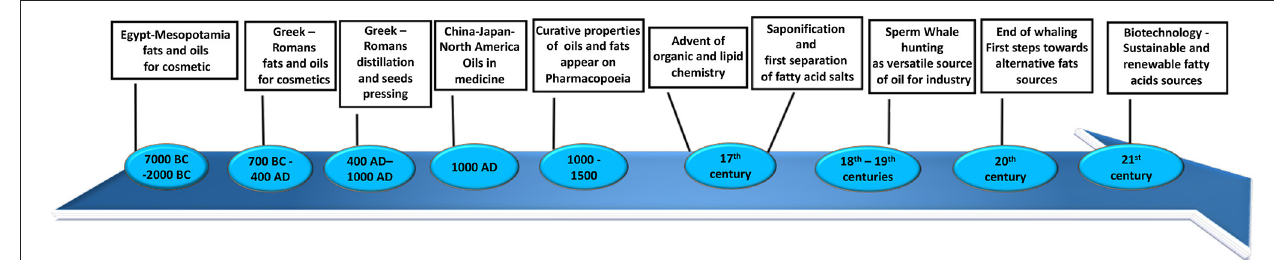
FIGURE 1 | Timeline of fatty acid source discovery, applications, and advances throughout